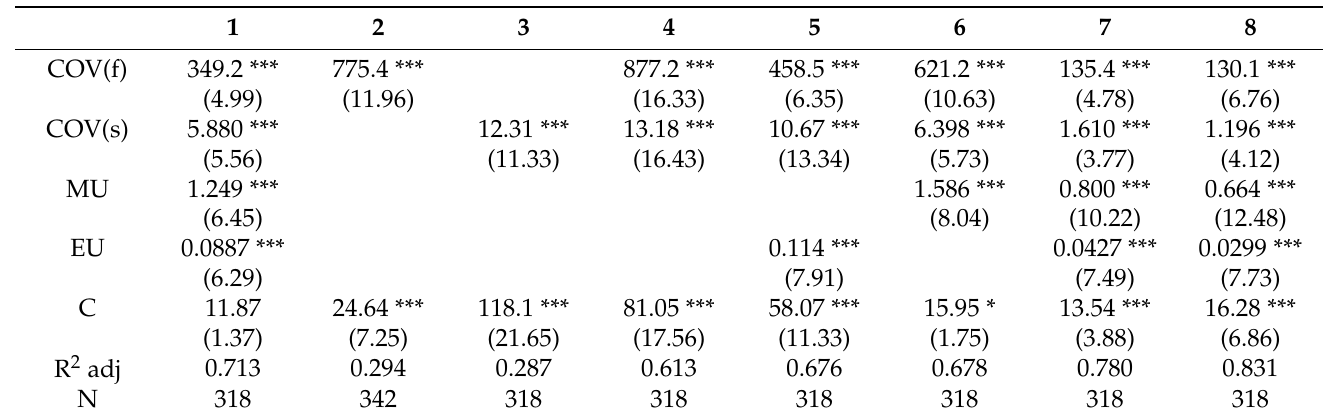
Table 3. COVID-19 death announcements and oil price volatility, European data.